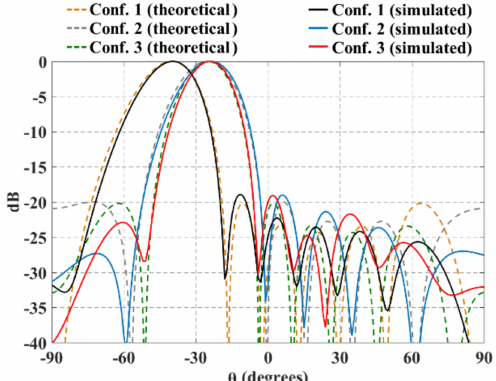
Figure 11. Radiation pattern in azimuth for the furthest scanning direction ( φ 0 = 90 ◦ , θ 0 = − 40 ◦ ) for configuration 1, ( φ 0 = 90 ◦ , θ 0 = − 25 ◦ ) for configuration 2 and ( φ 0 = 90 ◦ , θ 0 = − 25 ◦ ) for configuration